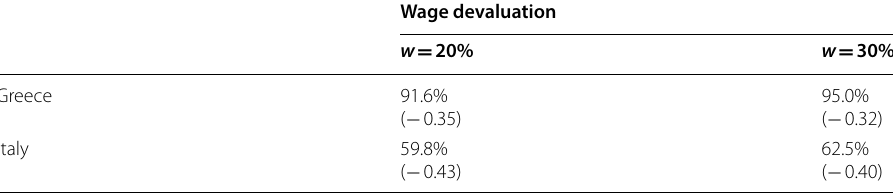
Table 10 The long-run effect of wage devaluation on the profit rate; Greece and Italy